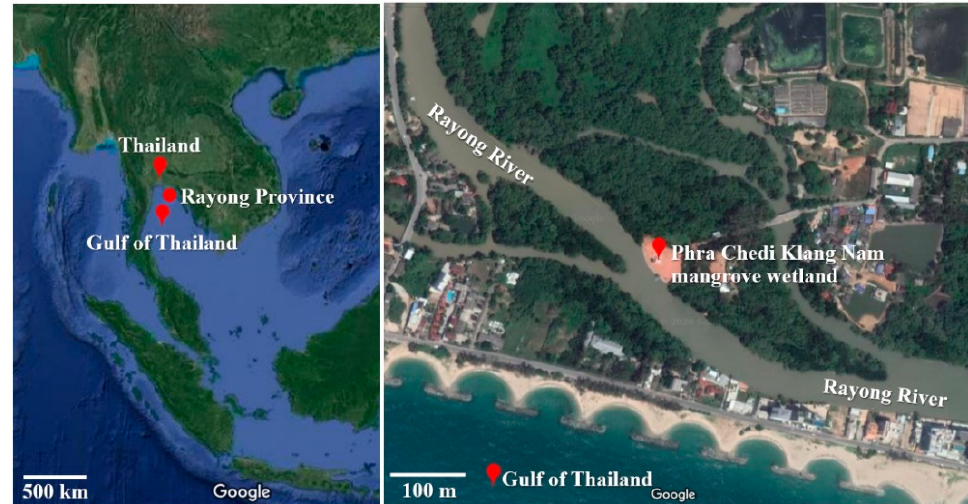
Figure 1. Location of the Phra Chedi Klang Nam mangrove wetland situated in Rayong Province, Thailand. (12°39 ′ N, 101°14 ′ E) (Source: Google Maps).